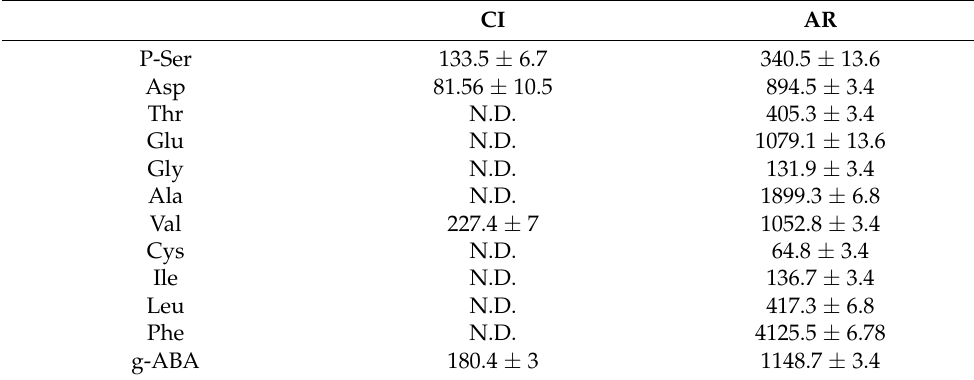
Table 3. Contents of amino acids in CI and AR.